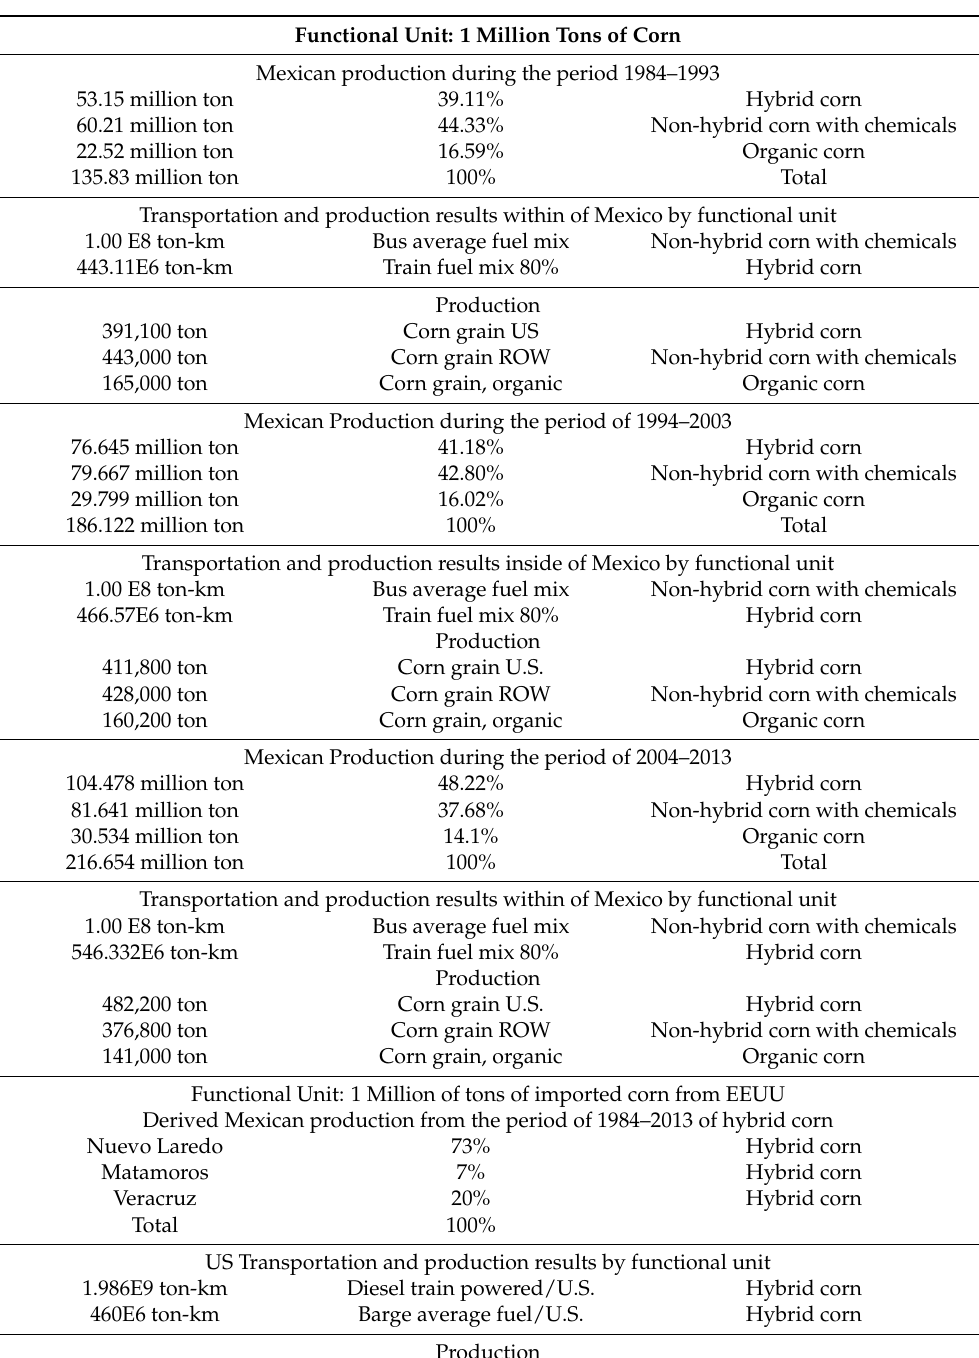
Table B1. Analysis by Functional